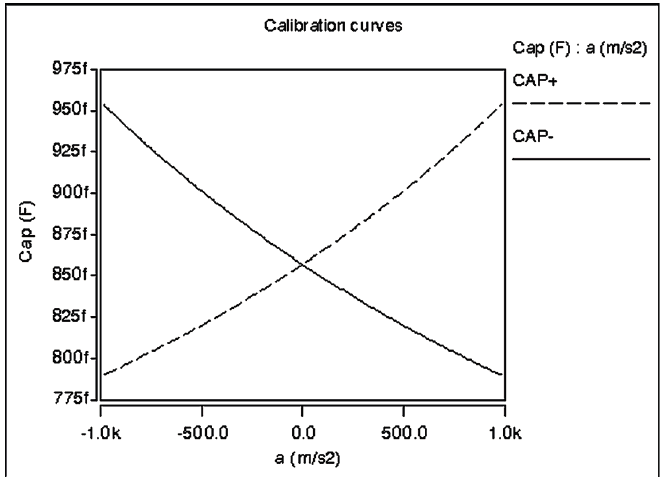
Figure 4. Electro-mechanical analysis showing the calibration curve response.